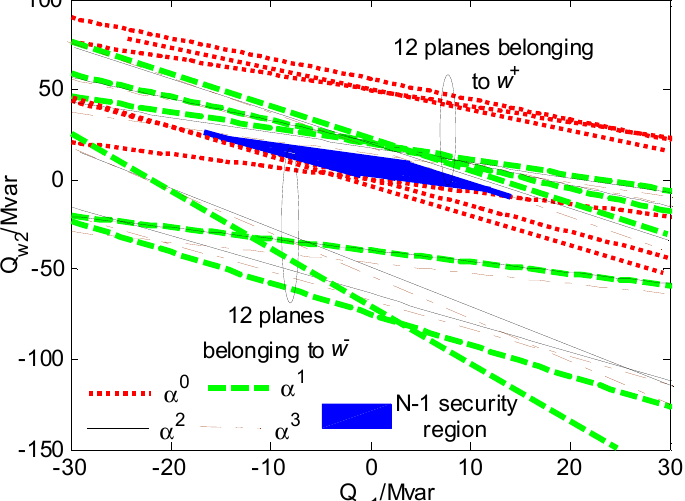
Figure 9. Projection of the N-1 voltage security region on the ( Q higher